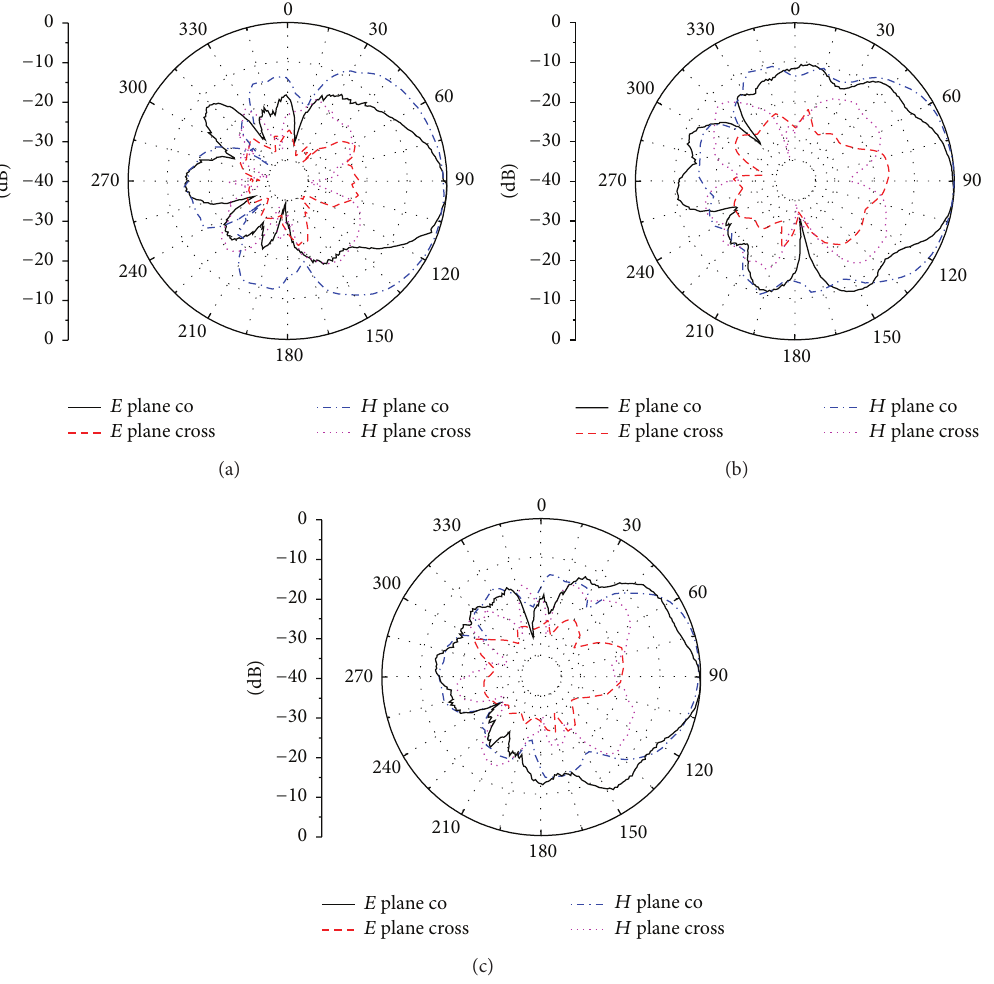
Figure 8: Normalized measured radiation patterns of single antenna at (a) 5 GHz, (b) 6 GHz, and (c)